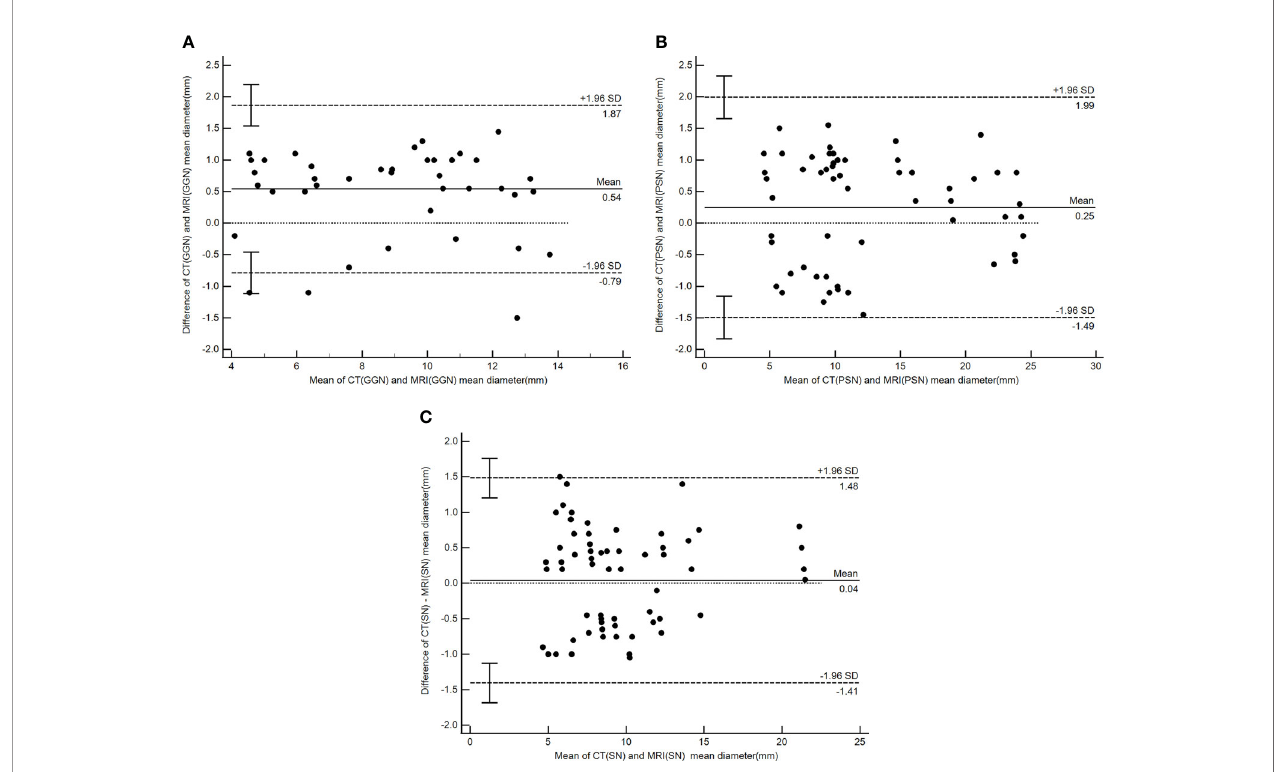
FIGURE 5 | Bland – Altman plot showing the agreement between the nodule mean diameter measurements by CT and PETRA for GGN (A) , PSN (B) and (C) SN respectively. Dashed lines denote 95%CI, and solid lines denote mean.